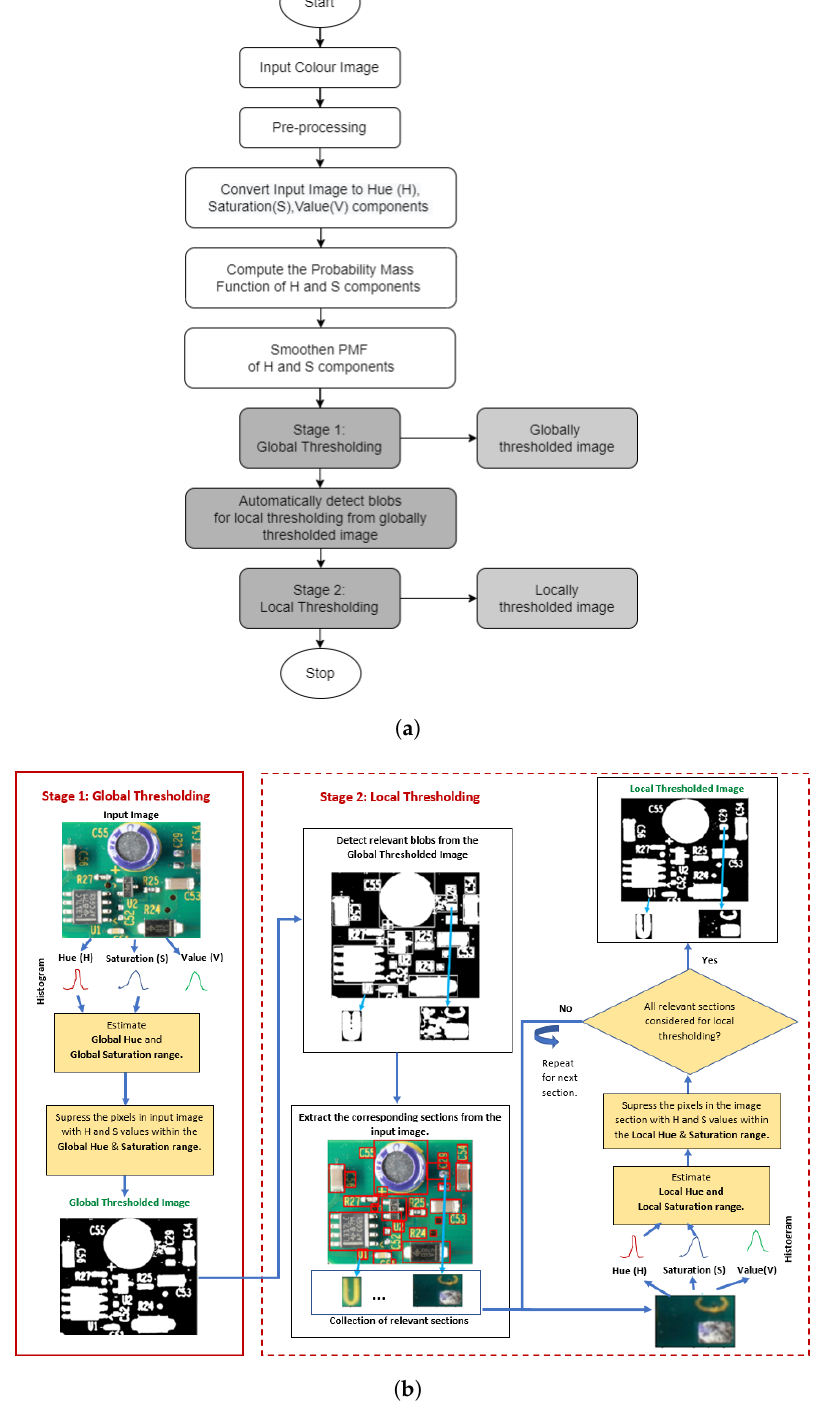
Figure 1. ( a ) Overall sequence of the two-stage global–local thresholding technique. Gray-shaded boxes indicate the key contributions of the proposed method. ( b ) Schematic overview of the global– local thresholding